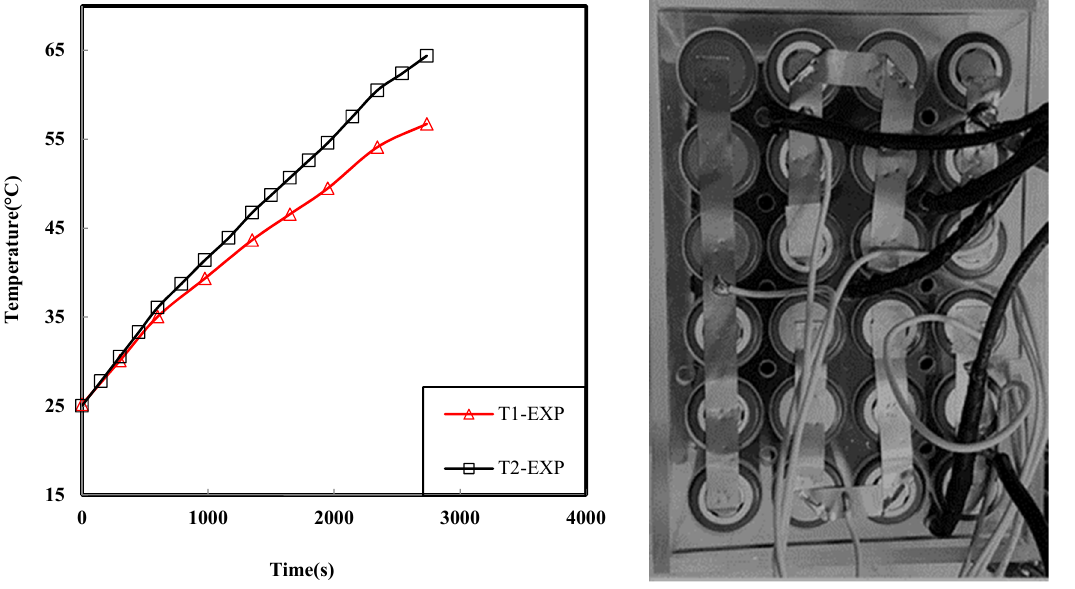
Figure 3. The temperature curve of the battery module and an image of the test setup for natural convection under a 1.5C discharging rate (EXP: Experimental).